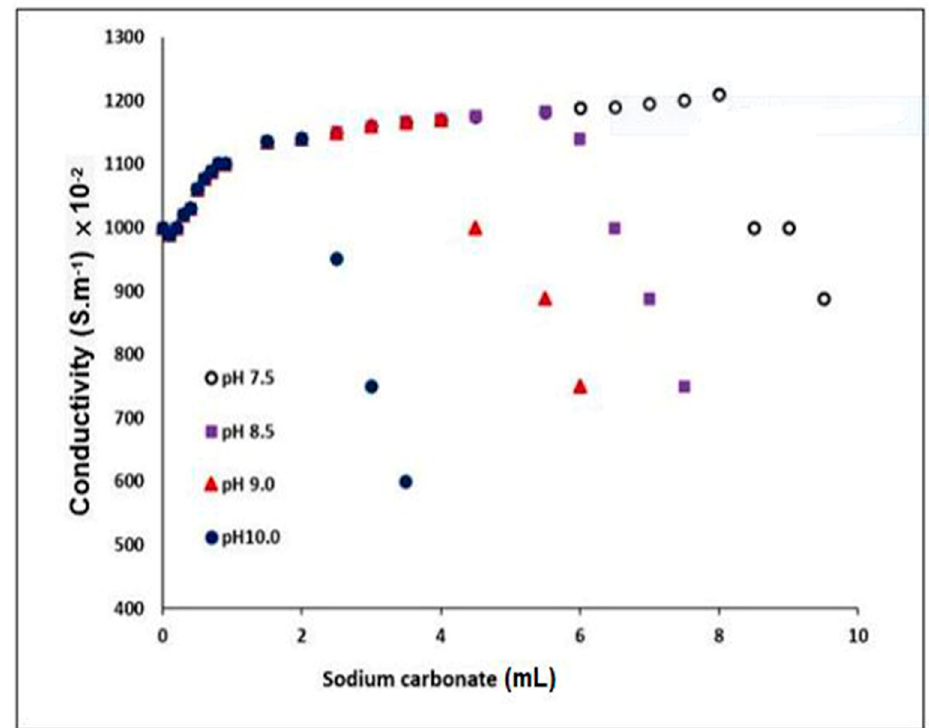
Figure 11. Variation in the conductivity in the presence of 10 mg·L − 1 of CA-co-GLC at 25 °C and in different pH of the media .